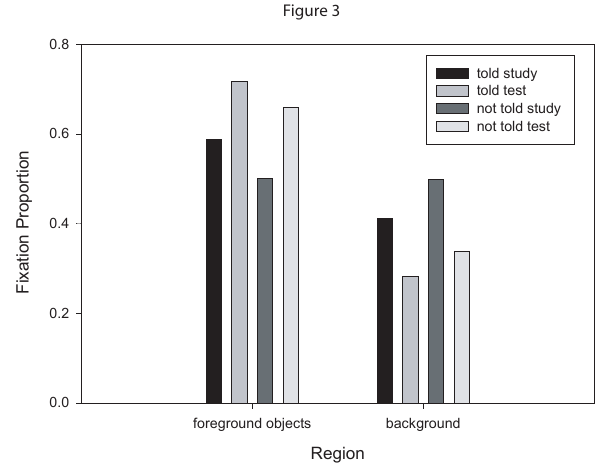
Figure 3. Area-normalized fixation proportions for the No People scenes as a function of Instruction (Told, Not Told), Session (Study, Test), and Region (foreground objects,